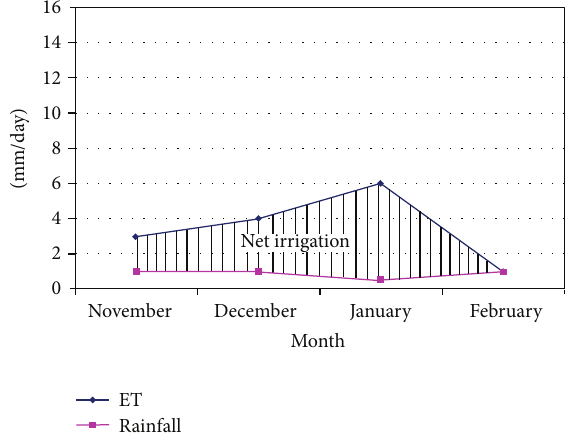
Figure 2: Net irrigation requirement of wheat